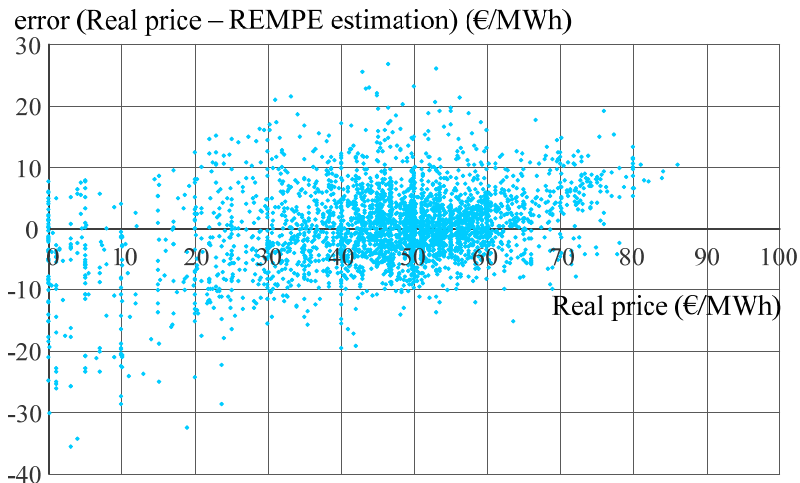
Figure 5. Error of the REMPE price estimation values versus actual price